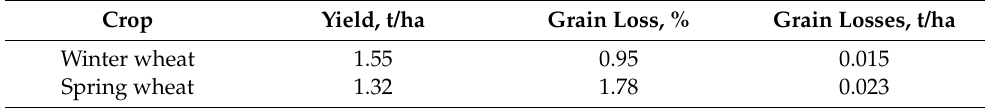
Table 4. Actual grain losses from wheat thrips on average in 2008–2012.